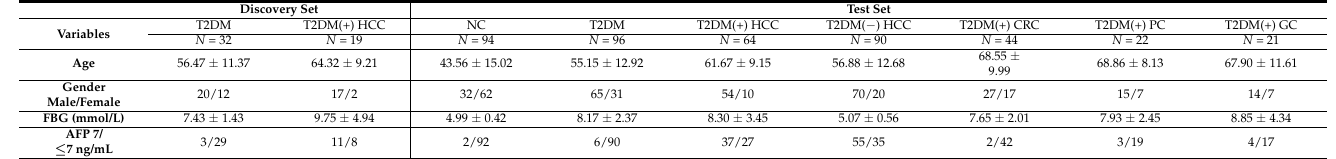
Table 1. The clinical features of individuals included in this